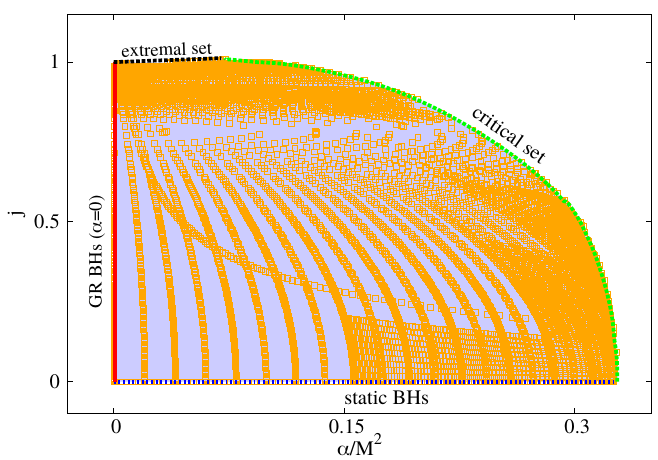
Figure 3 . Domain of existence of EsGB spinning BHs in a j vs: (cid:11)=M 2 diagram. Here and in (cid:12)gure 4, all quantities are normalised w.r.t. the mass of the solutions. The domain is obtained by extrapolating into the continuum over twenty thousand numerical points. Each such point corresponds to an individual BH solution, and is represented in this plot as a small orange circle. points into the continuum. The (cid:12)gure shows that the domain of existence is delimited